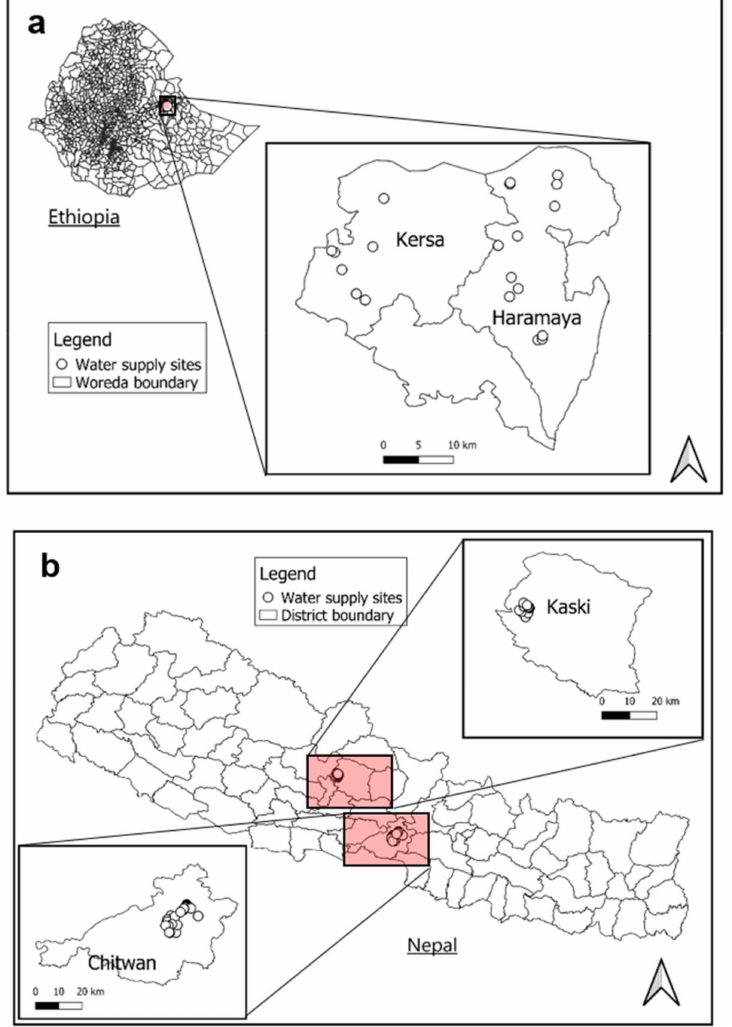
Figure 1. Locations of water supply sites in ( a ) Ethiopia and ( b )